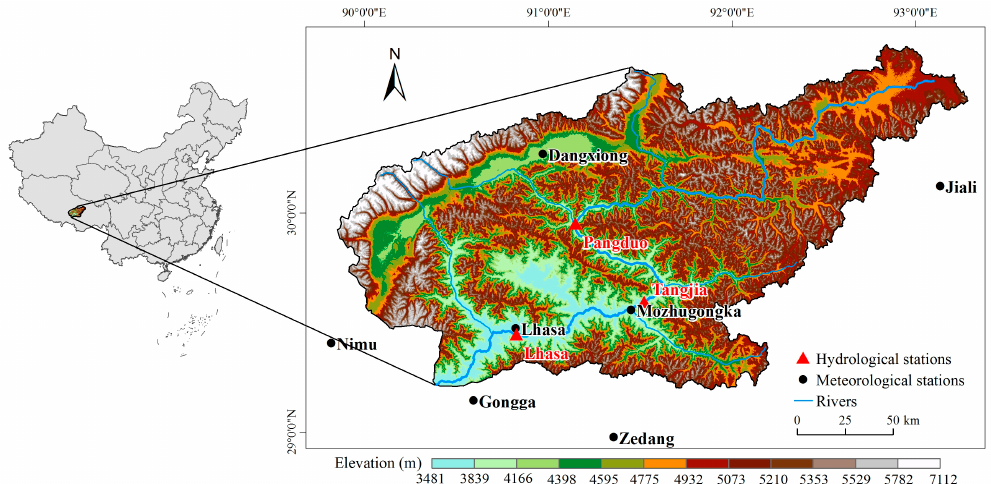
Figure 1. The location of the Lhasa River Basin and the hydrological stations and meteorological stations in this area.